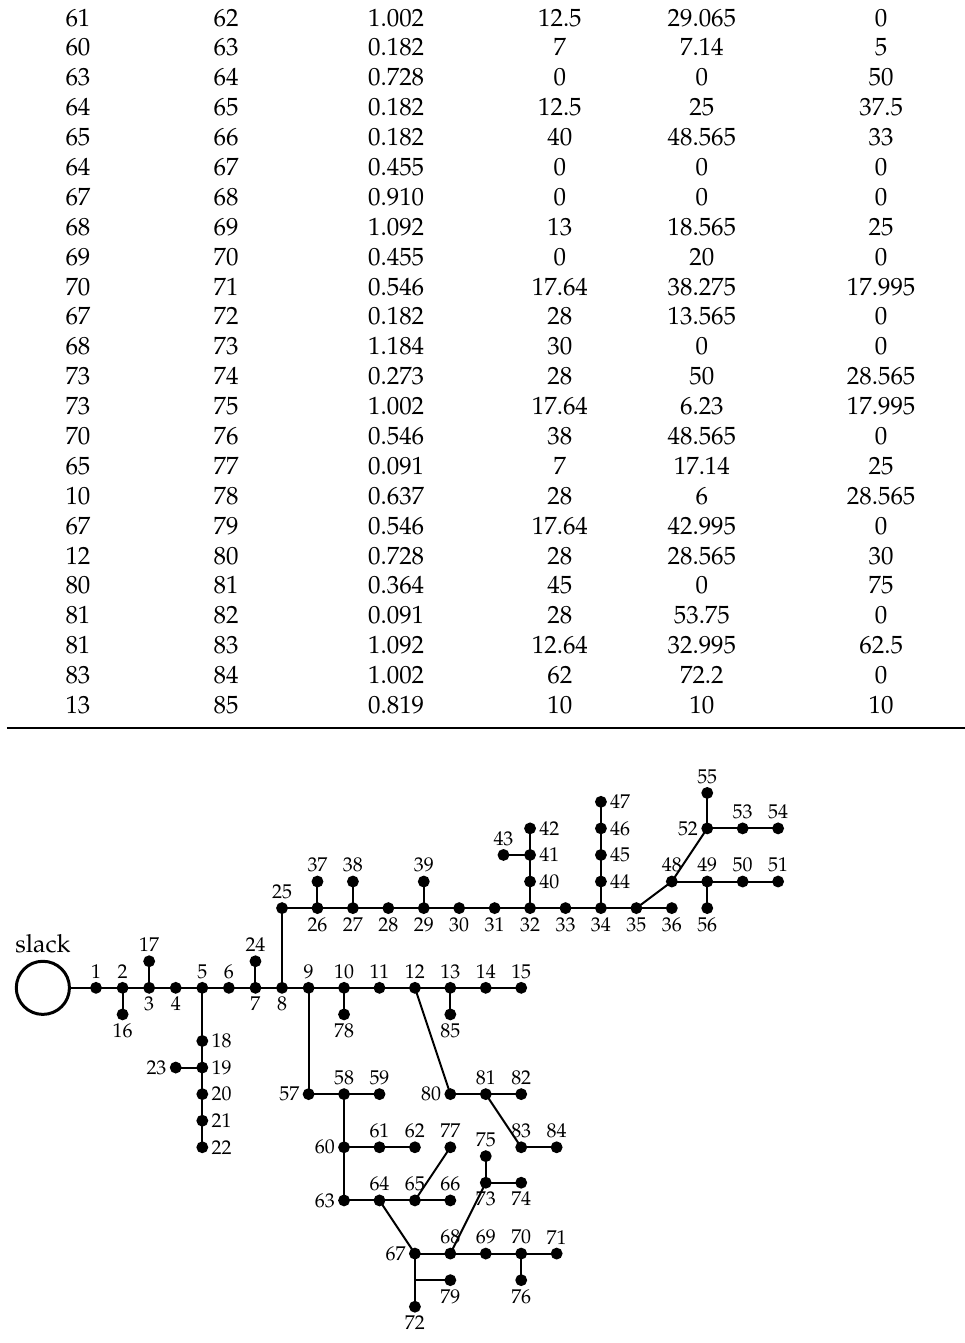
Figure 4. Grid topology of the IEEE 85-bus system for bipolar power flow